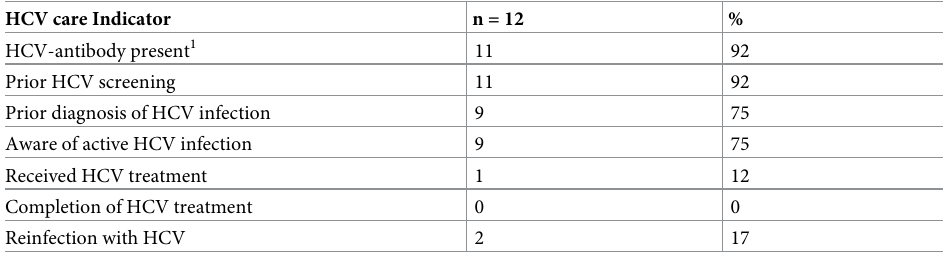
Table 4. HCV care indicators among trans women with HCV viremia. HCV care